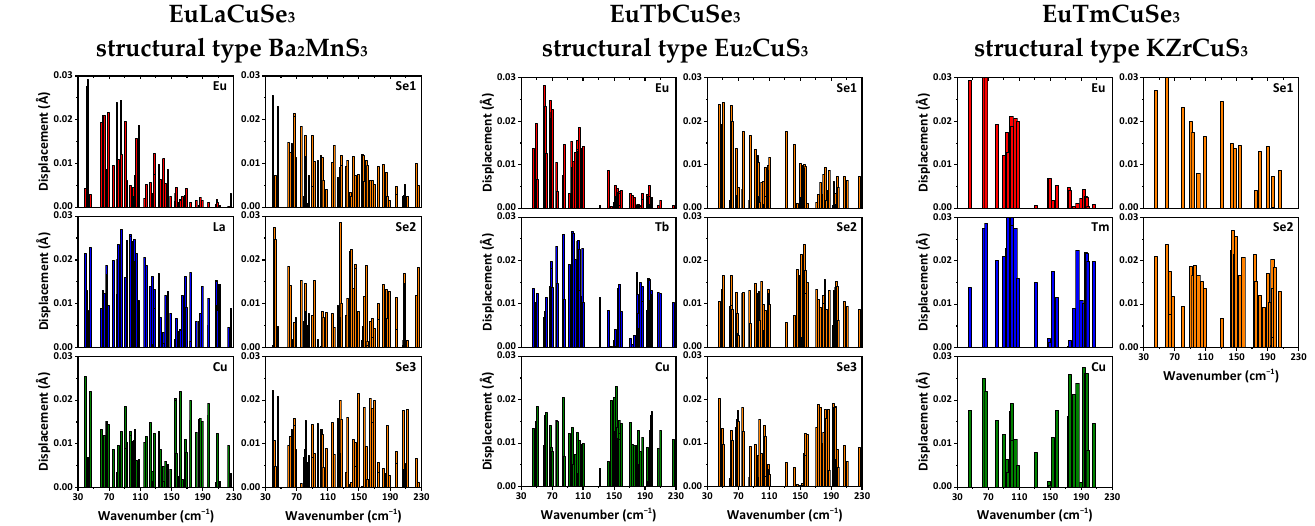
Figure 6. The displacement of ions at phonon modes in EuLnCuSe 3 (Ln = La, Tb, Tm). According to the obtained results, the phonon wavenumbers at the Γ -point do not exceed 230 cm − 1 . In this range, not only light ions of selenium and copper but also heavy rare-earth ions are actively involved. In crystals of EuLnCuSe 3 with a structural type of Ba 2 MnS 3 , the europium ions actively participate in modes with wavenumbers up to about 150 cm − 1 , while for the structural types of Eu 2 CuS 3 and KZrCuS 3 , the europium ions participate in modes with wavenumbers up to about 110 cm − 1 , respectively (Figure